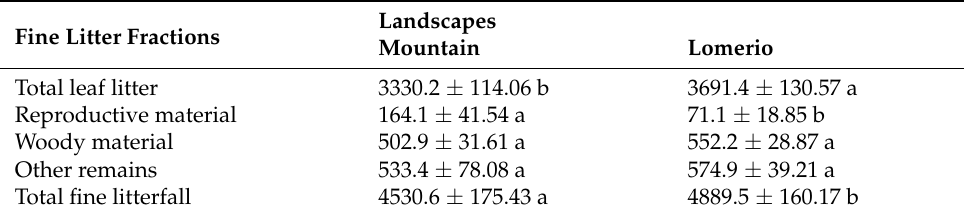
were observed (Figure 4). Leaf litterfall of A. graveolens (r = − 0.75; p < 0.0125), P. acapulcensis (r = − 0.60; p = 0.0483) and P. pinnatum (r = − 0.88; p < 0.0035) showed a negative correlation eolens (r = − 0.83; p < 0.0058) and C. alliodora (r = − 0.66; p = 0.0276) for the Lomerio landscape.